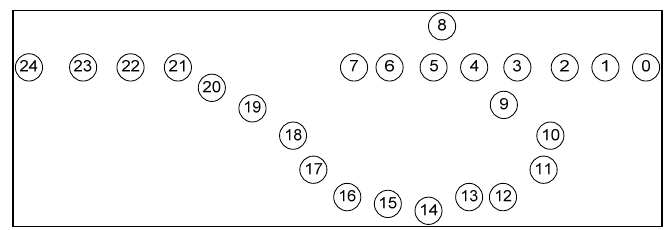
Figure 16. Open void on L